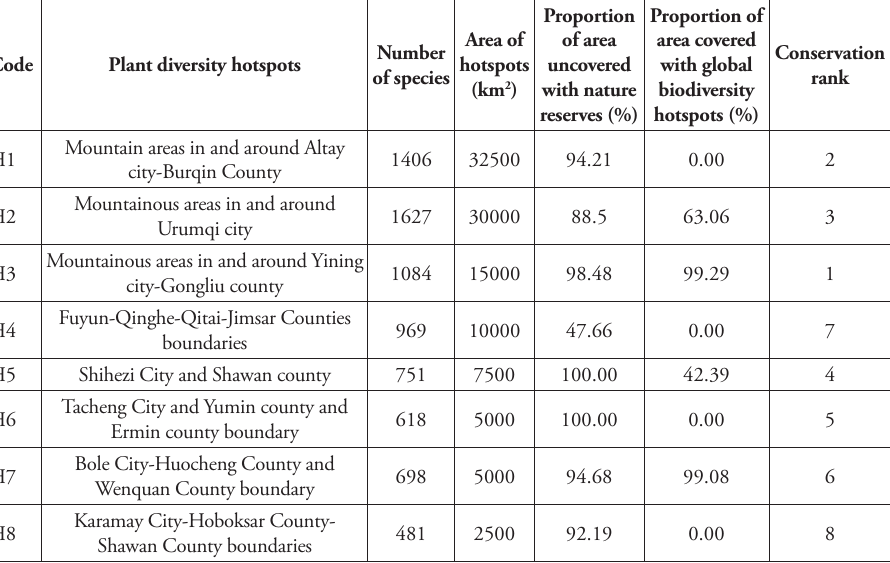
Table 3. Seed plant diversity hotspots and conservation ranks in Xinjiang. Code Plant diversity hotspots